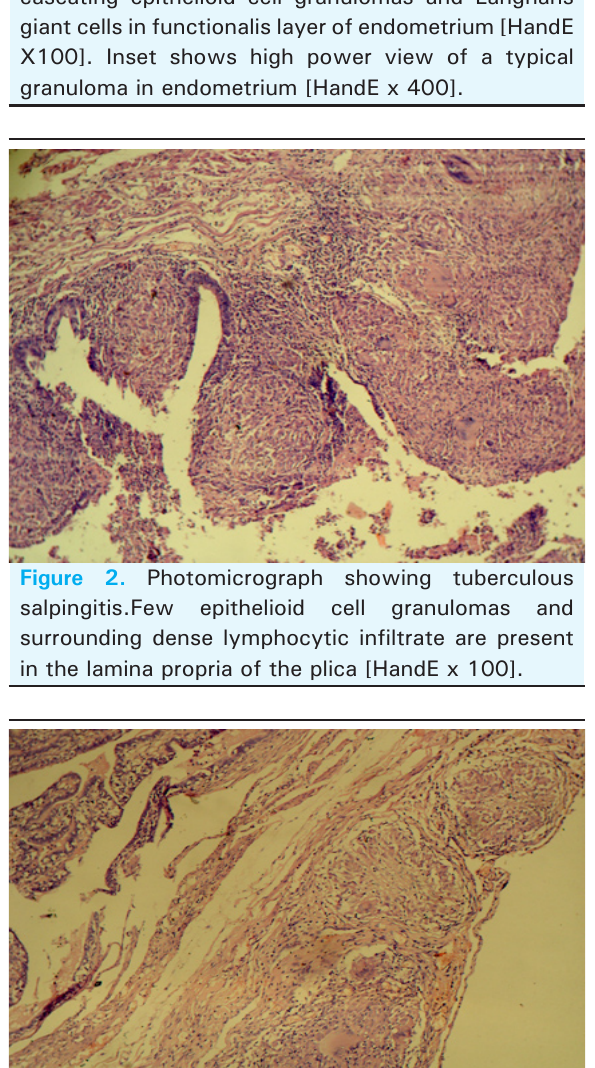
figure 6. Agarose gel electrophoresis showing PCR-based detection of DNA of Mycobacterium tuberculosis. Lane No.1: marker panel, Lane No. 2: Positive control (123 and 383 bp band), Lane No.3: Negative control, Lane No.11and17: positive test